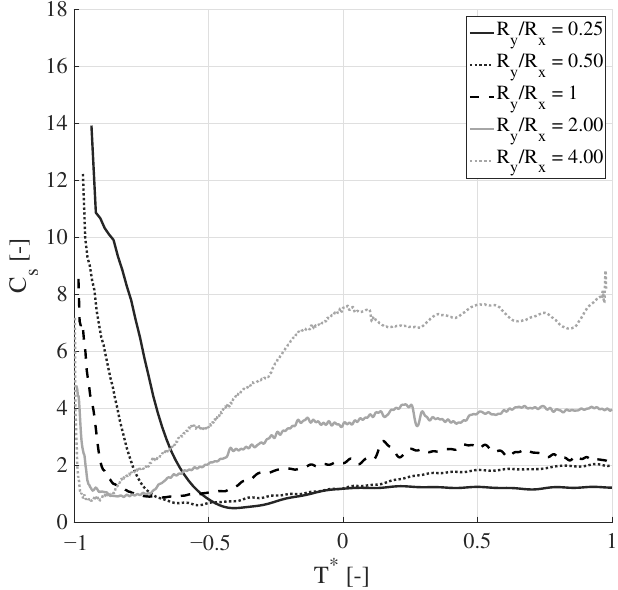
Figure 22. Evolution of the new slamming coefficient as a function of the non-dimensional time. Solid black line represents aspect ratio of 0.25, dotted black line 0.5, dashed black line the circular obstacle with R y / R x = 1.0, solid light gray line the aspect ratio of 2.0, and dotted light gray line the largest aspect ratio of